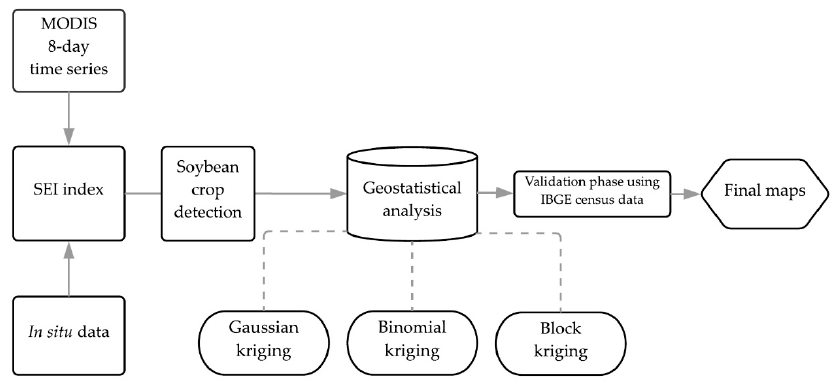
Figure 4. Technical flowchart.